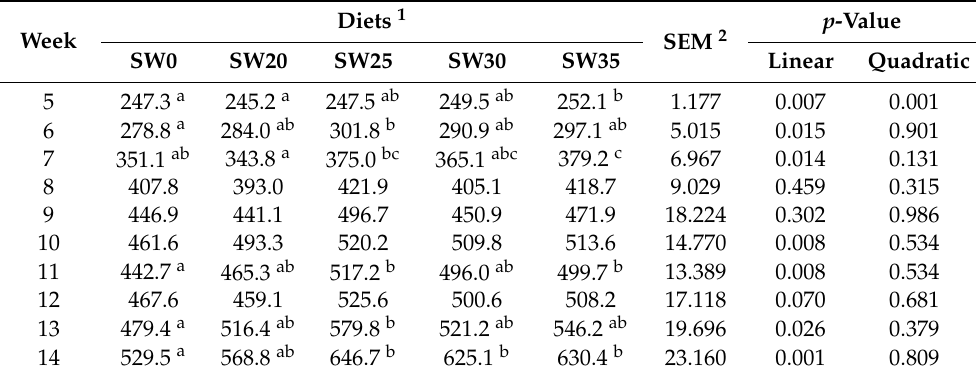
Table 4. Average weekly feed intake (g / bird) of Boschveld indigenous hens fed diets containing seaweed meal.